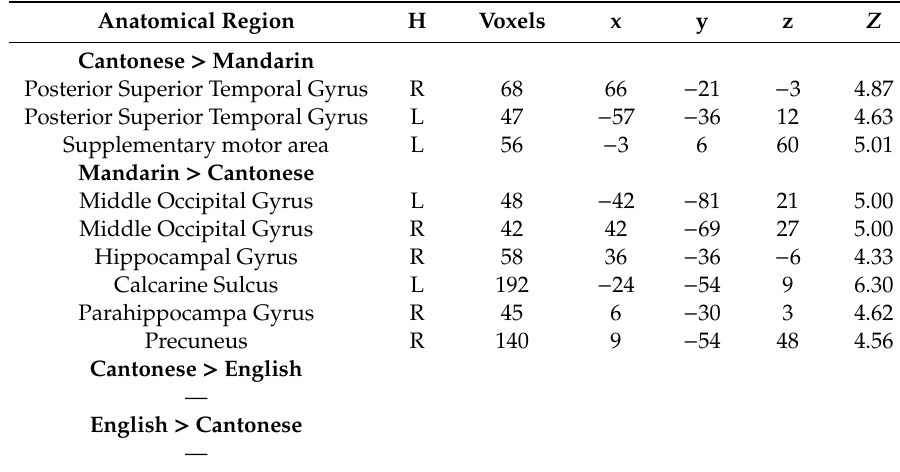
Table 6. Brain activity for the contrast of rhyming minus control for the group comparisons in auditory